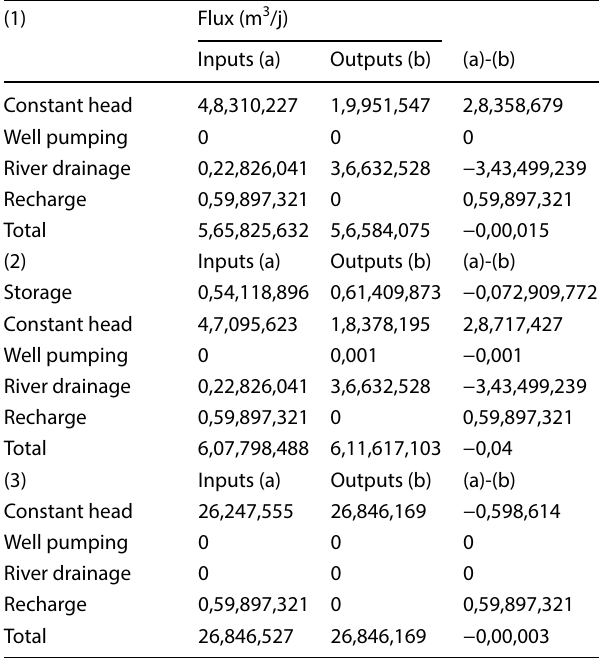
Fig. 8 Observed sulfate concentrations in the study